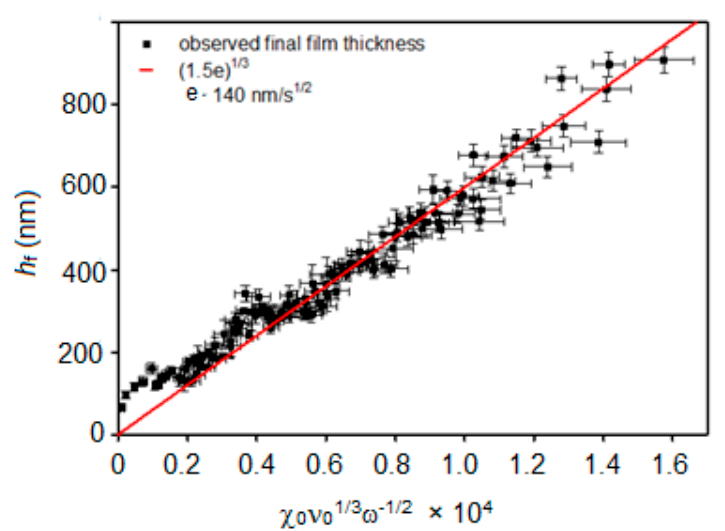
Figure 8. Film thickness as a function of deposition parameters, Equation (4). The slope of the lin- ear fit (red line) gives the static evaporation rate, e . Error bars are the standard deviation of at least 3 measurements per point.